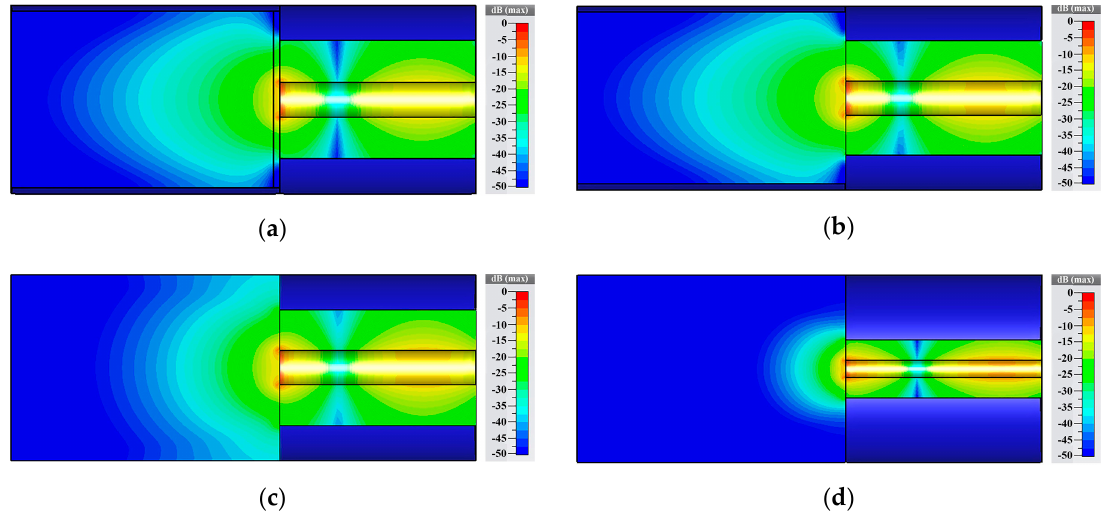
Figure 3. Electric field simulation results at 4 GHz: ( a ), the proposed sensor with isolation layer; ( b ), sensor without isolation layer; ( c ), coaxial sensor; ( d ), coaxial sensor with small radii of inner and outer conductor.